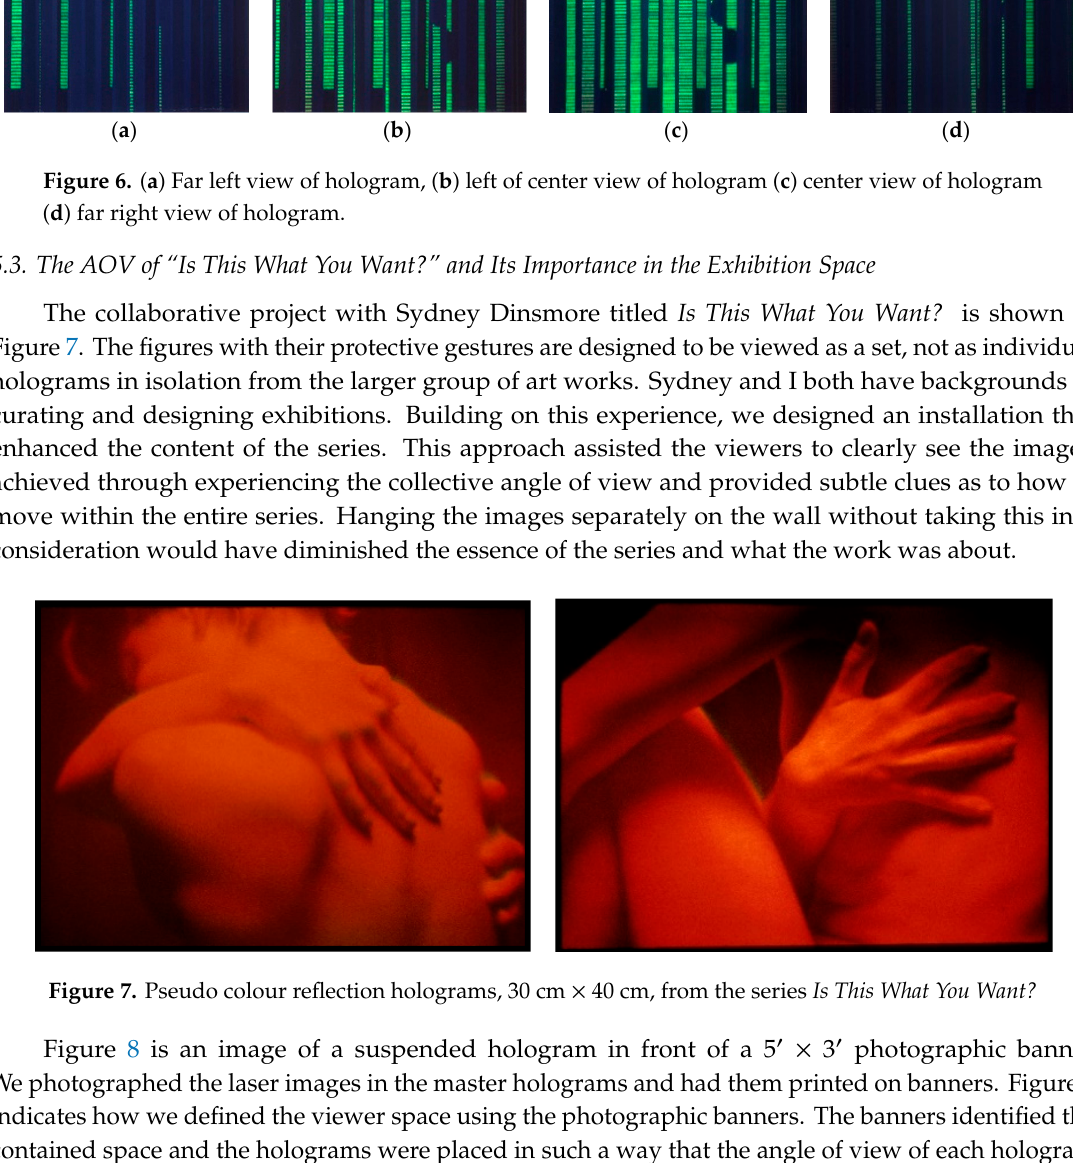
(cid:48) × (cid:48) 3 photographic